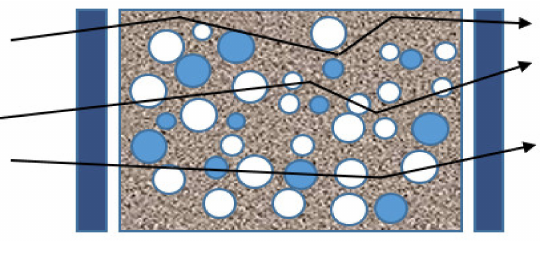
Figure 7. Conductive